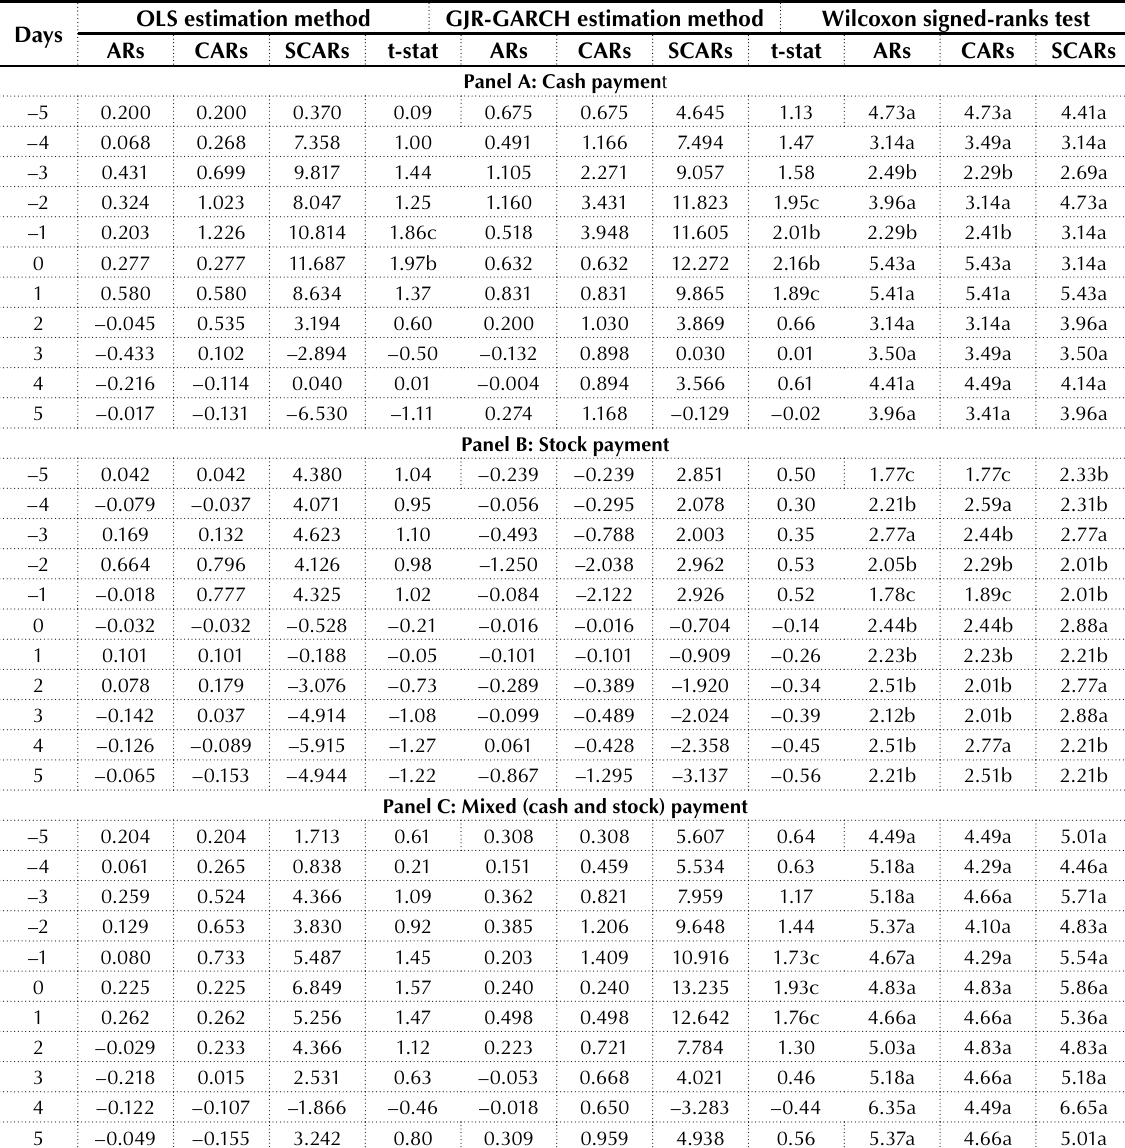
Table 4. Average ARs measures around announcements for acquirers by payment method OLS estimation method GJR-GARCH estimation Days